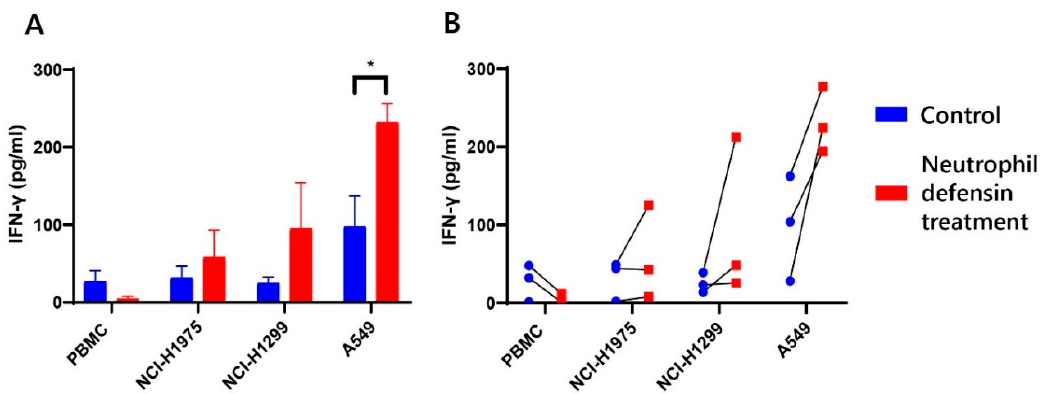
Figure 7. IFN- γ secretion in the supernatants of in-vitro cocultures treated with neutrophil defensin 1, 2 and 3. PBMC alone or cocultured with NSCLC cells (NCI-H1975, NCI-H1299, A549) were treated with neutrophil defensin 1, 2 and 3 (Red, 5 µ M) or PBS (Blue, control) for 3 days. Thereafter, supernatants were used to determine the amount of IFN- γ . ( A ) Means ± SEM of PBMC from three healthy donors after 66 h treatment with neutrophil defensins. This results in a significant increase (* p = 0.05) of IFN- γ concentration for A549; ( B ) Increase in IFN- γ concentration for each donor individually.